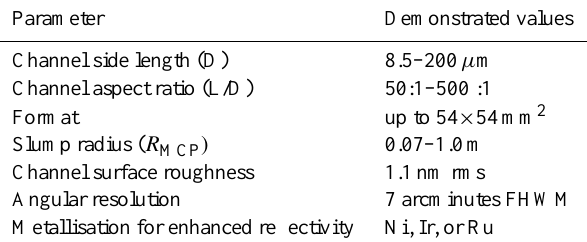
Table 4. MCP optic properties adopted for the ray tracing study (the effective area is wavelength independent in the FUV band con- sidered